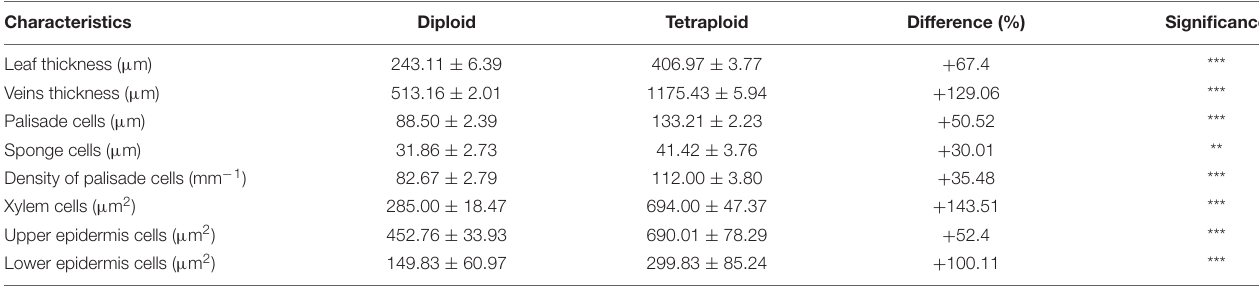
FIGURE 4 | Paraffin section of a diploid and tetraploid leaf in E. urophylla. (A) Vein anatomical structure of the diploid; (B) vein anatomical structure of the tetraploid; (C) leaf anatomical structure of the diploid; and (D) leaf anatomical structure of the tetraploid. XC, xylem cells; UEC, upper epidermis cells; LEC, lower epidermis cells; SC, sponge cells; PC, palisade cells. TABLE 4 | The leaf anatomical structure of diploid and tetraploid Eucalyptus urophylla